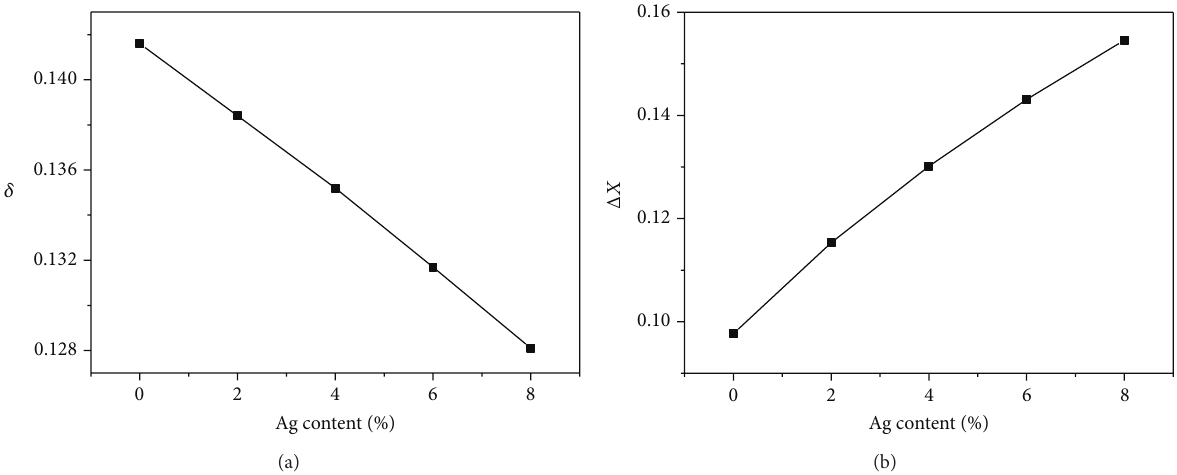
Figure 4: The atomic size parameter 𝛿 (a) and the electronegativity difference Δ𝑥 (b) of Ti 41 Zr 25 Be 34−